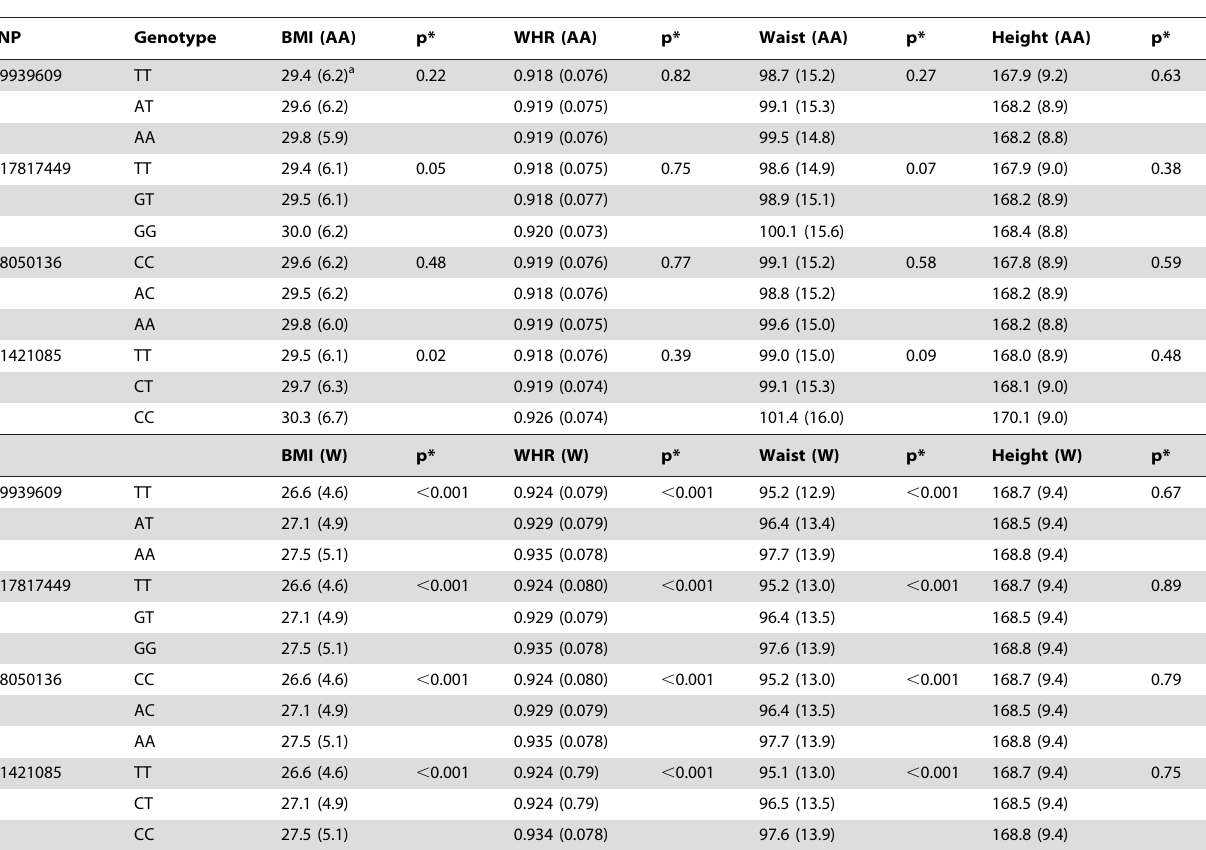
Table 3. Association of FTO genotype and quantitative traits stratified by